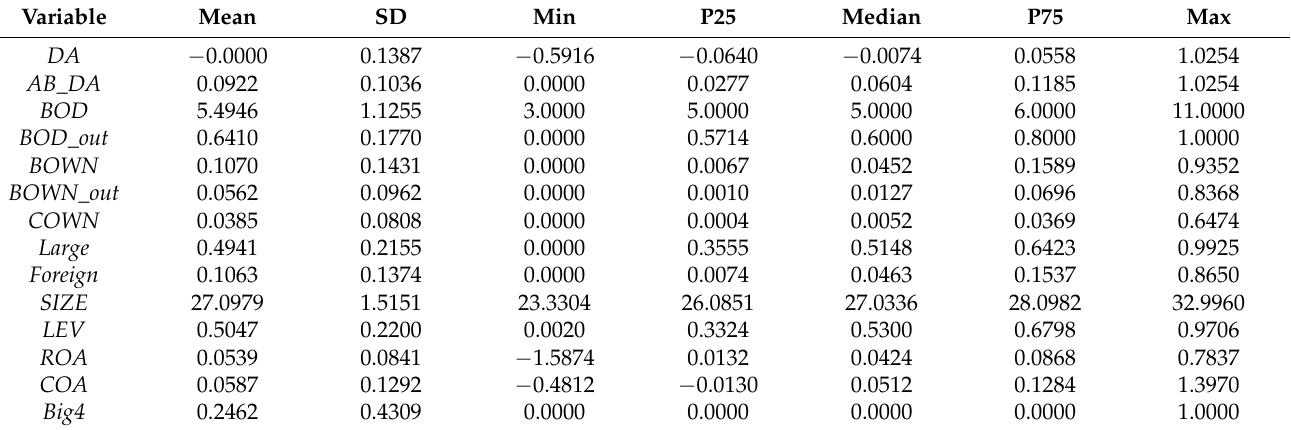
Table 1. Summary